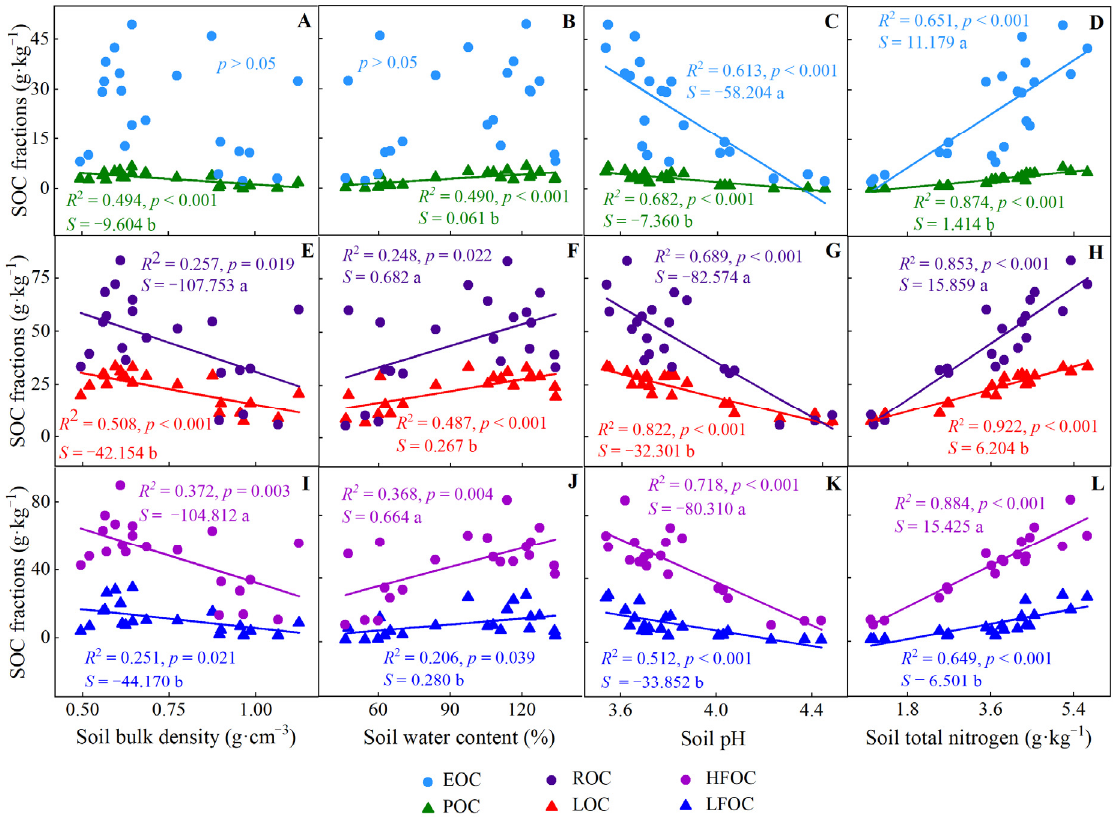
Figure 4. Estimation and analysis of standardized principal axis between soil physicochemical prop- erties and carbon fractions in C. japonica plantation in the rainy area of western China. ( A – D ) analysis between EOC and POC with soil bulk density, water content, pH and total nitrogen, respec- tively; ( E – H ), analysis between ROC and LOC with soil physicochemical properties, respectively; ( I – L ), analysis between HFOC and LFOC with soil physicochemical properties, respectively. S: slope. Different lowercase letters denote the correlation between the slope of two straight lines in the same box is significantly different.